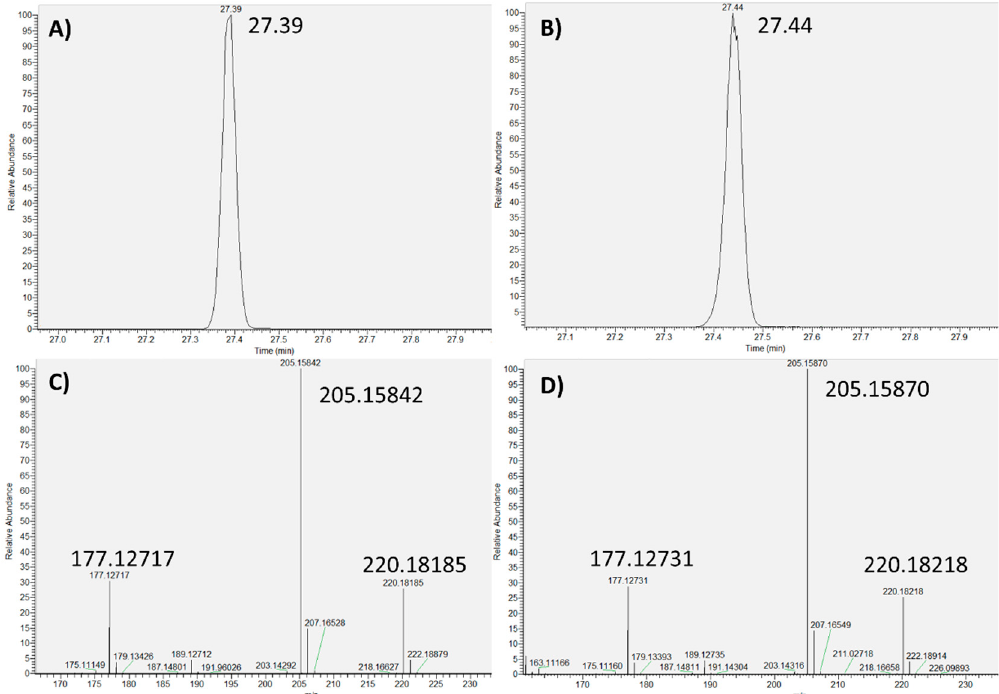
Figure 2. Butylated hydroxytoluene (BHT): ( A ) Base peak (standard); ( B ) Base peak (sample); ( C ) MS spectrum (standard); ( D ) MS spectrum (sample).